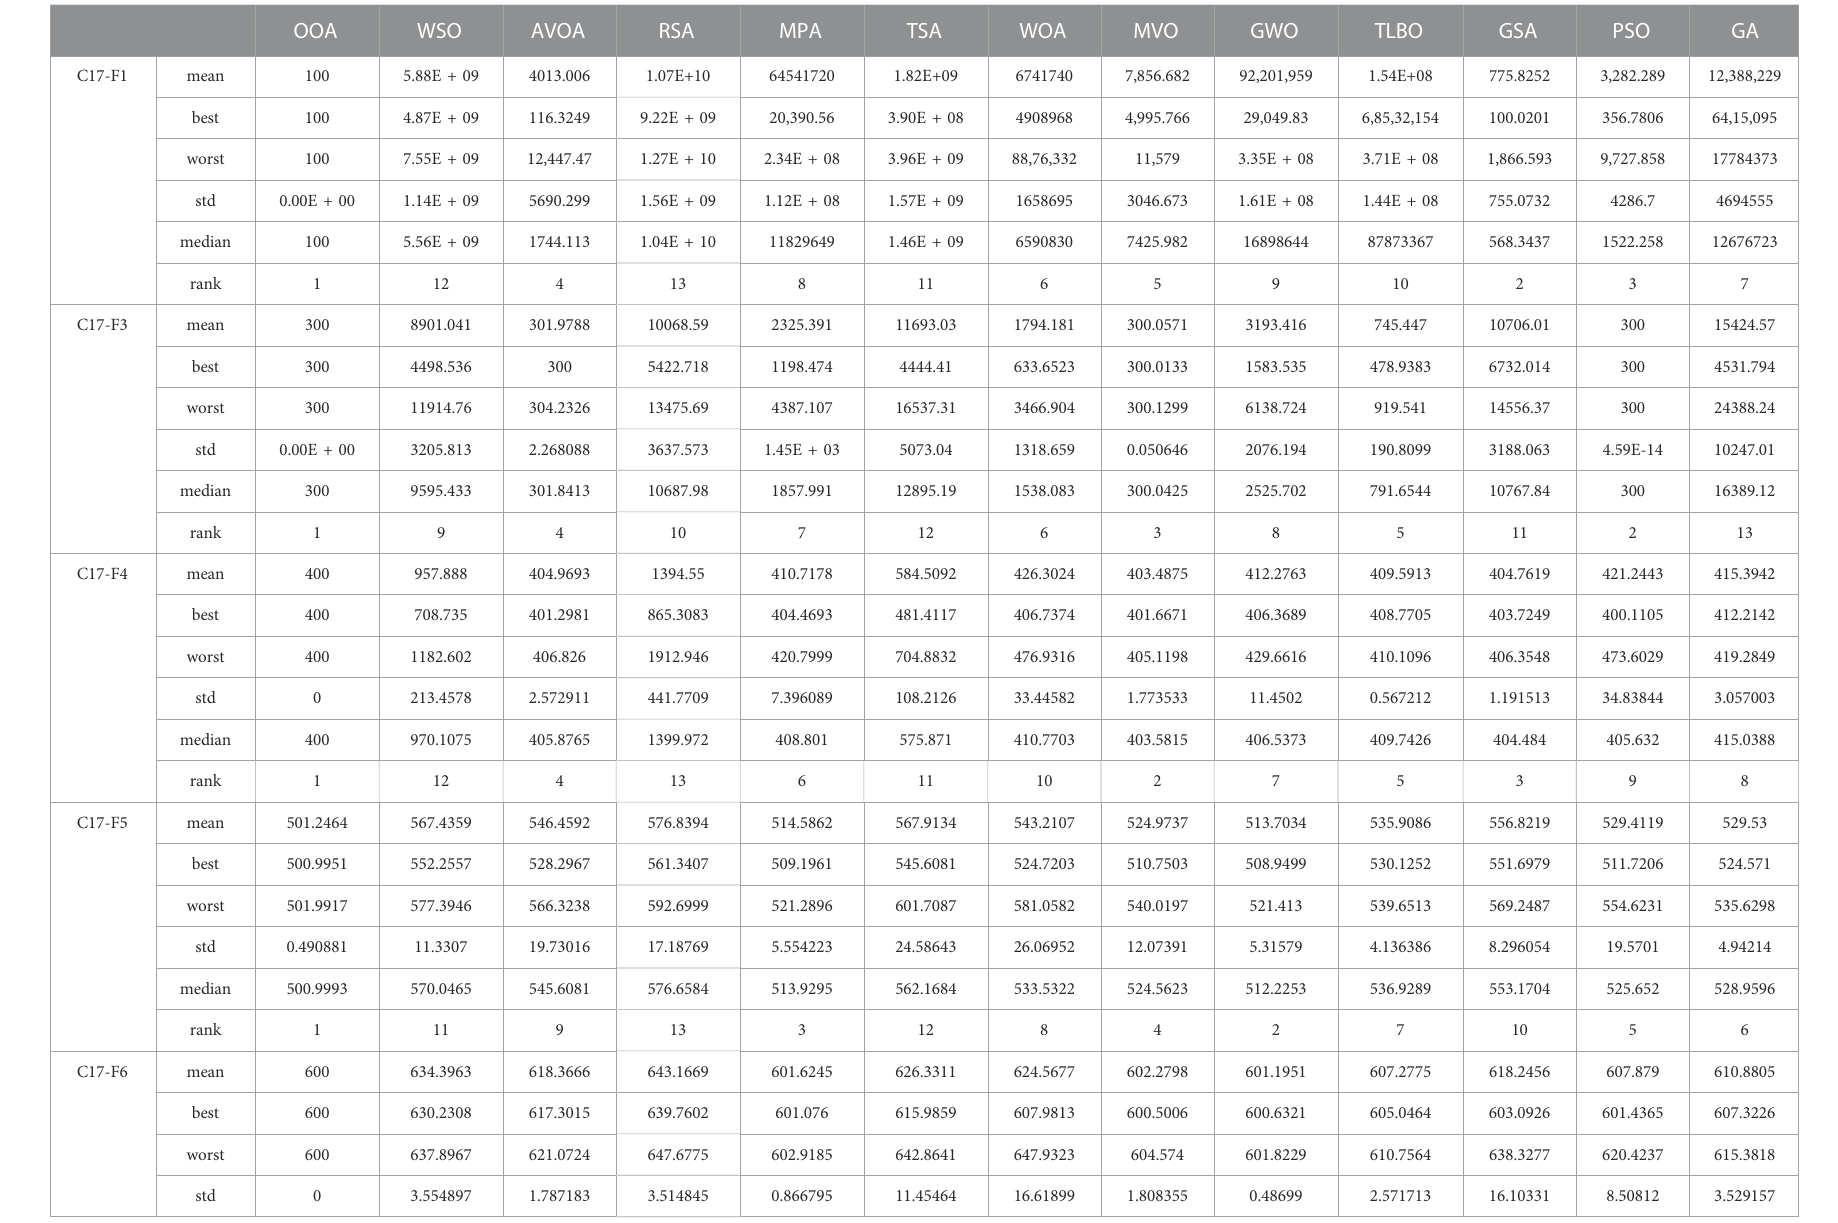
TABLE 2 Performance of optimization algorithms on the CEC 2017 test suite ( D (cid:1) 10